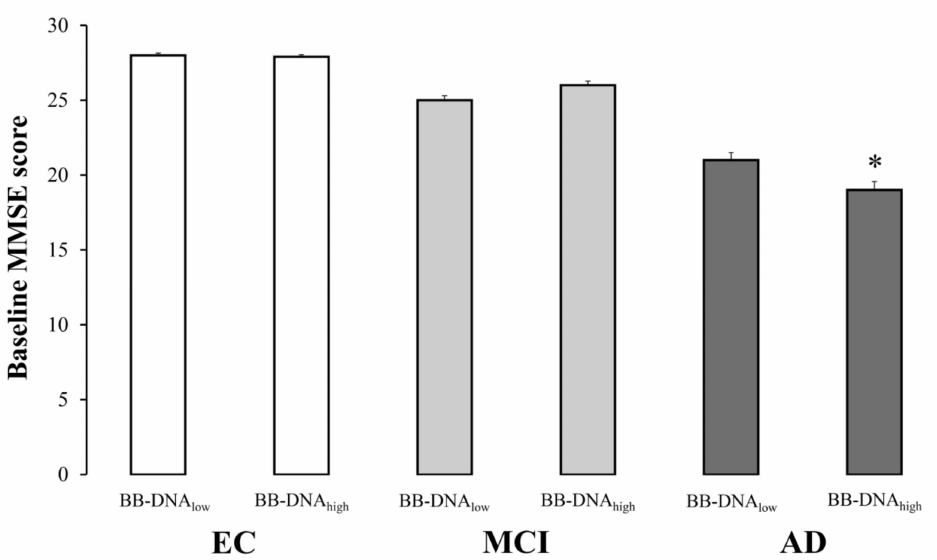
Figure 2. The baseline Mini Mental State Examination (MMSE) scores in elderly controls (EC), mild cognitive impairment (MCI) and Alzheimer’s disease (AD) subjects in accordance with blood bacterial DNA (BB-DNA) percentiles. AD patients with BB-DNA above the median value (3.78 ng/mL) showed the lowest MMSE scores. No significant differences were observed in MCI subjects and EC. ANCOVA analysis adjusted for age, sex, education, and IADL was applied. * p < 0.05 as compared to BB-DNA low in AD